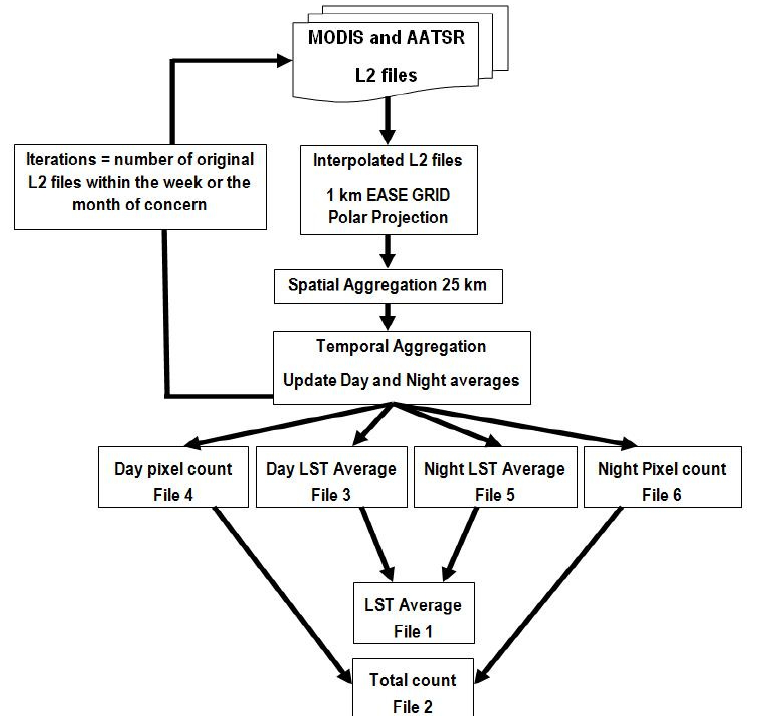
Figure 1. Flow diagram of the processing chain used to produce pan-Arctic LST L3 products from original L2 un-projected LST 1-km